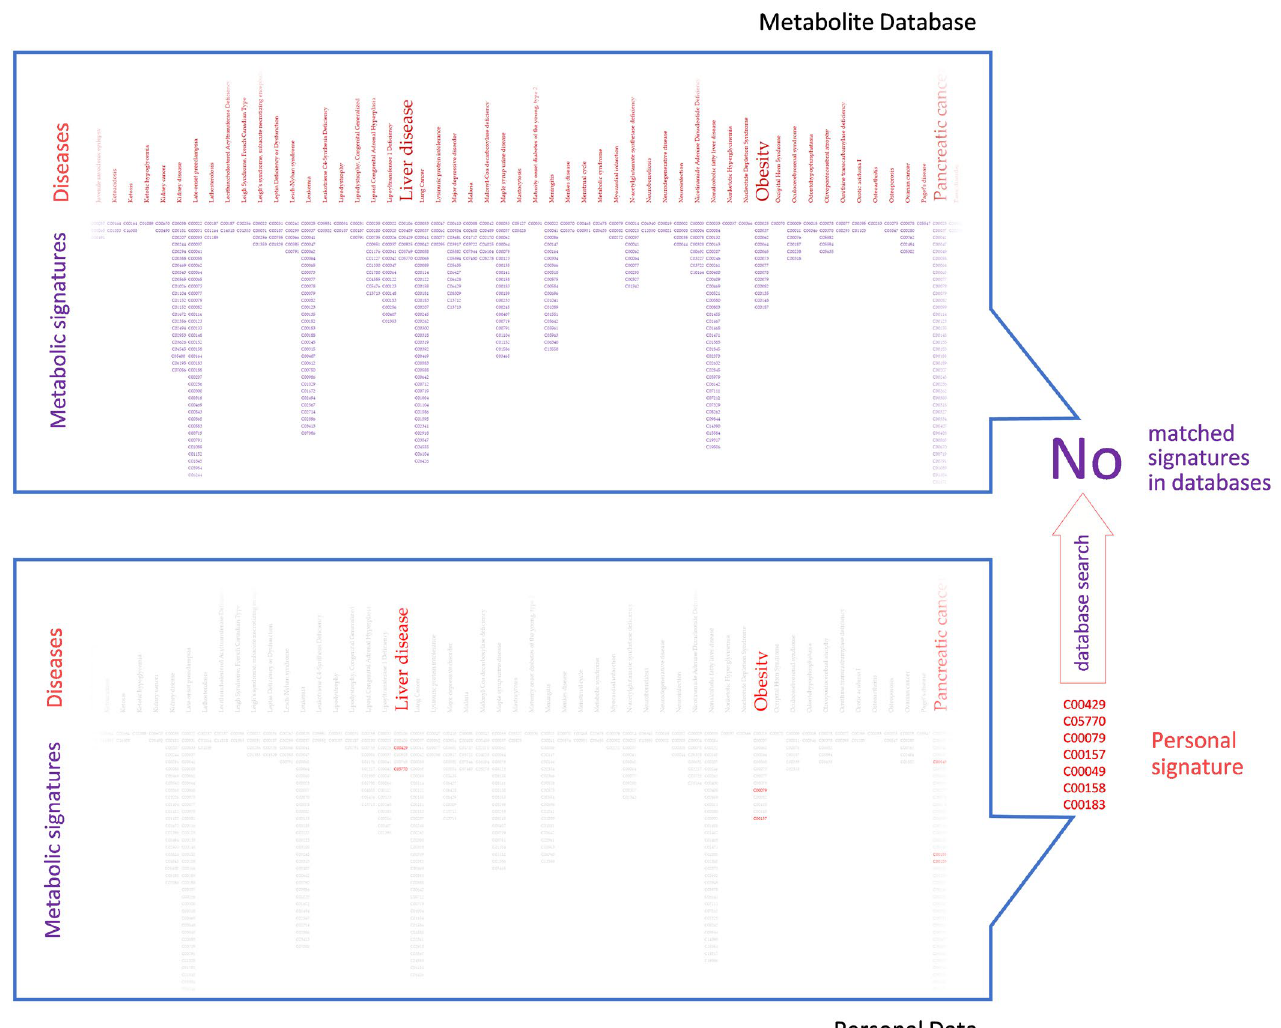
Figure 4. The problem of personal data searching against a metabolic database. The medley of fragmented signatures in personal data is searched against disease or other signatures in the database, leading to no matched signatures. Kyoto Encyclopedia of Genes and Genomes identifiers are shown for the metabolites.